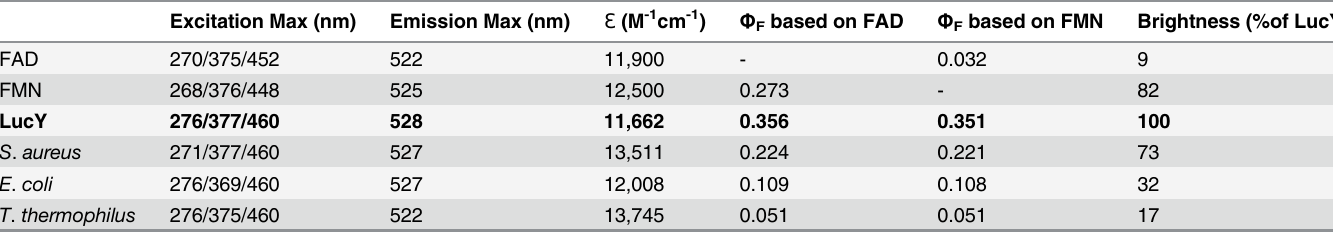
Table 1. Fluorescence characteristics of LucY and other MurB